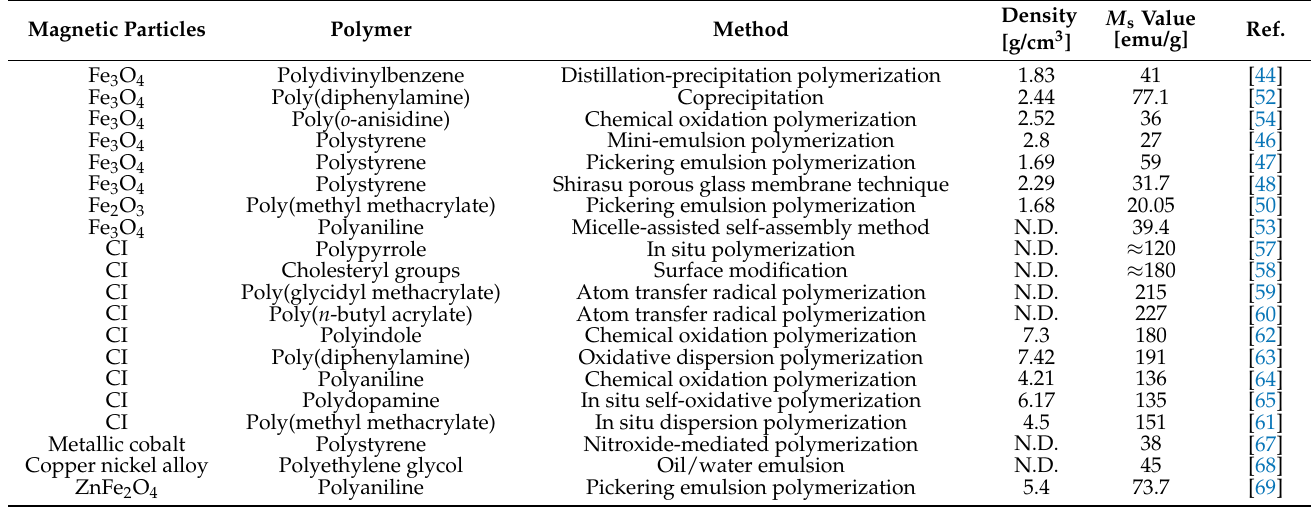
Table 1. Preparation methods for various magnetic polymer composites and their magnetic properties (the abbreviation “N.D.” denotes “not